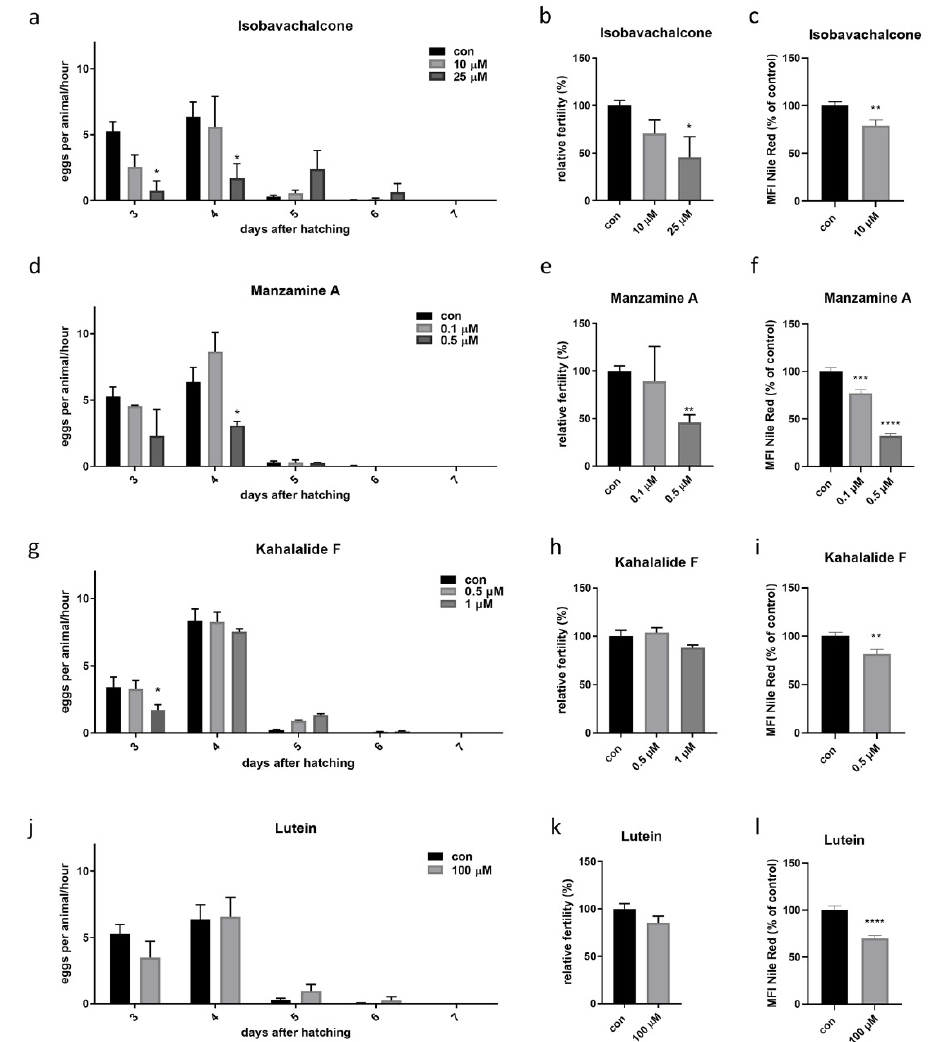
Figure 3. Fertility rate and fat content upon treatment with the four hit compounds. The treatment with the four compounds started from eggs on solid media. ( a , d , g , j ) Show the effect on fertility, expressed as eggs laid per animal per hour. ( b , e , h , k ) Show the effect of compounds on relative fertility, measured as the sum of total eggs laid in the entire fertile period, normalized on 100% of control. ( c , f , i , l ) Show the effect of compounds on fat content normalized on 100% of control (Mean Fluorescence Intensity, MFI). Measurements are indicated as mean ± SEM. One-way ANOVA. In all panels, asterisks (*) denote statistical significance, * p value ≤ 0.05, ** p value ≤ 0.01, *** p value ≤ 0.001, **** p value ≤ 0.0001 compared with control.